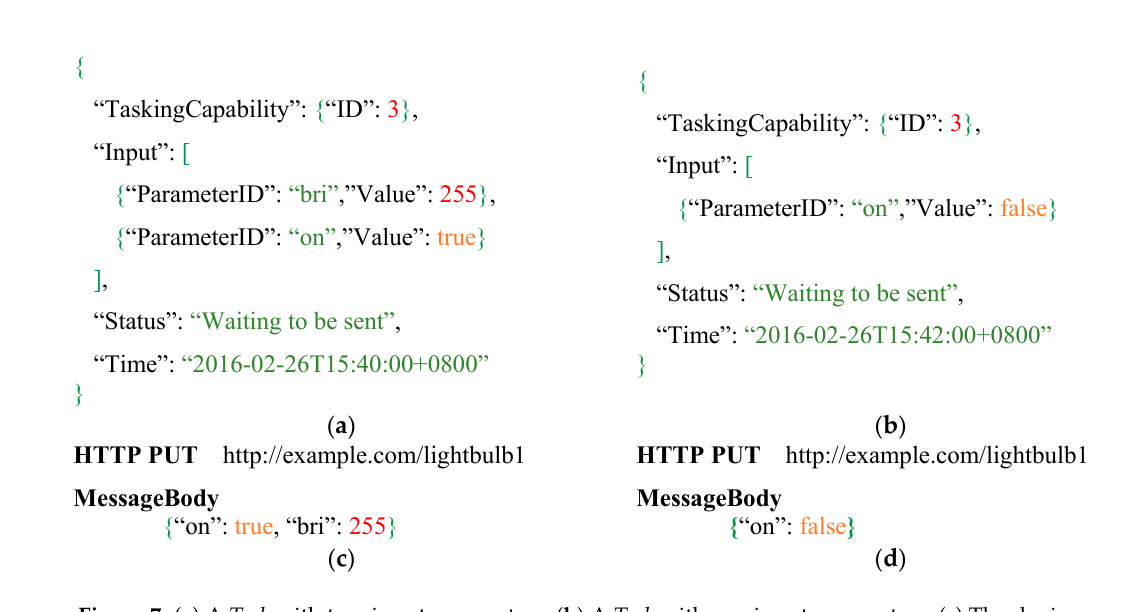
Figure 7. ( a ) A Task with two input parameters; ( b ) A Task with one input parameters; ( c ) The device request corresponds to the two-input-parameters Task ; ( d ) The device request corresponds to the one-input-parameter Task .